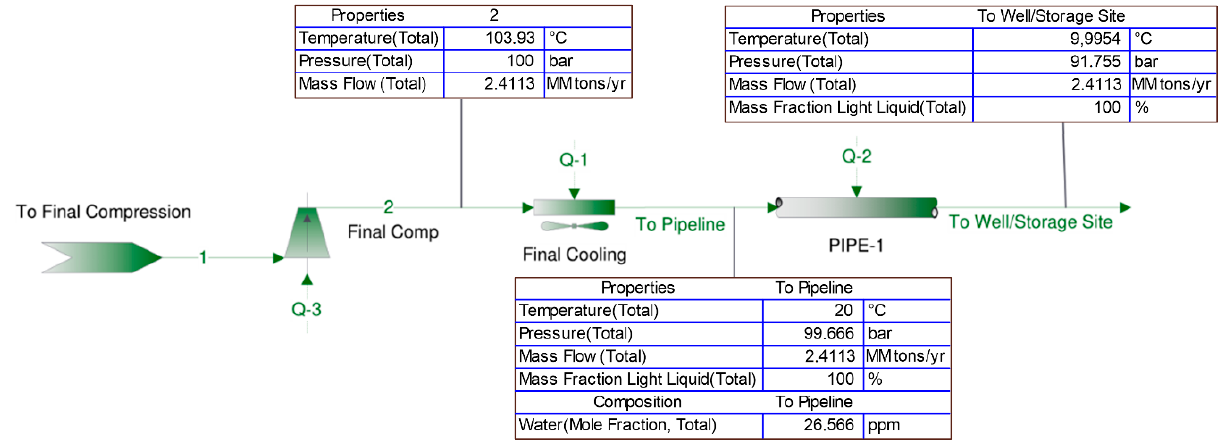
Figure 5. Final compression, cooling, and transport to the storage site.